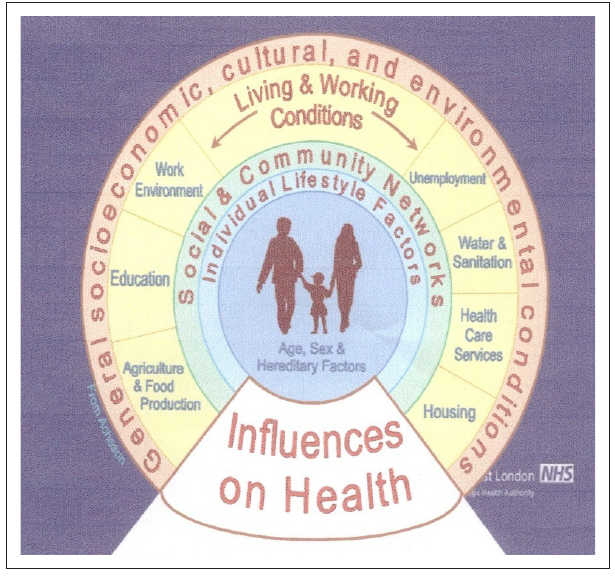
FIGURE 1: The Main Determinants of Health